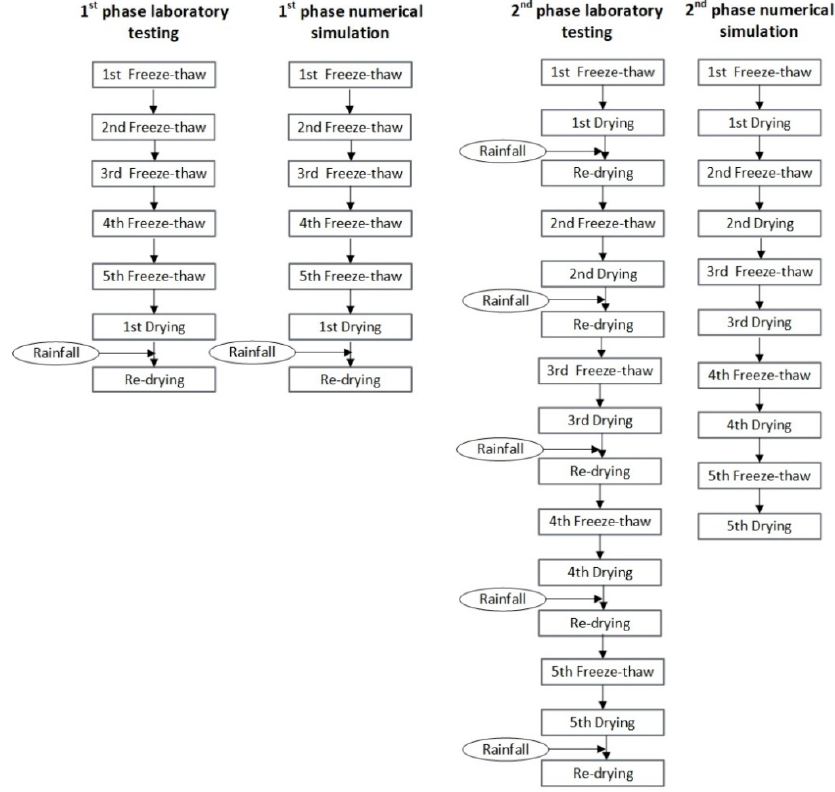
Figure 4. First ‐ and second ‐ phase laboratory testing and numerical simulation sequences. Figure 4. First- and second-phase laboratory testing and numerical simulation sequences.